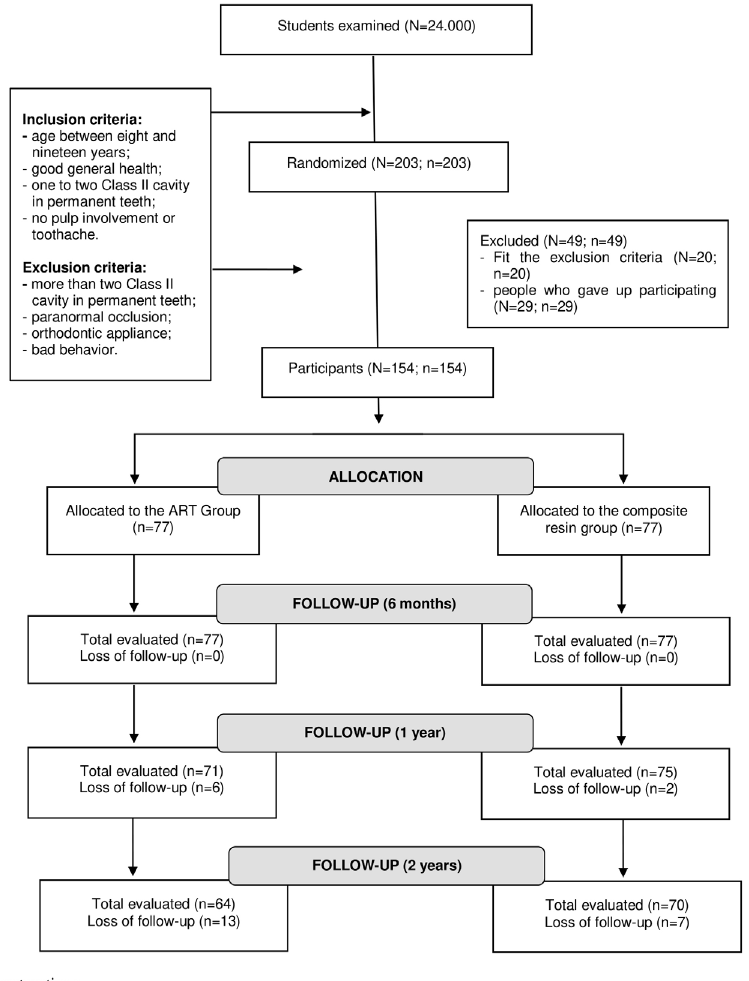
Figure 1- CONSORT flowchart for clinical